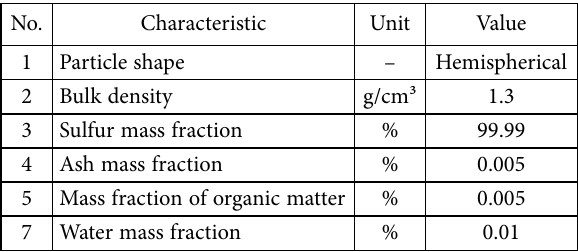
Table 1. Characteristics and chemical